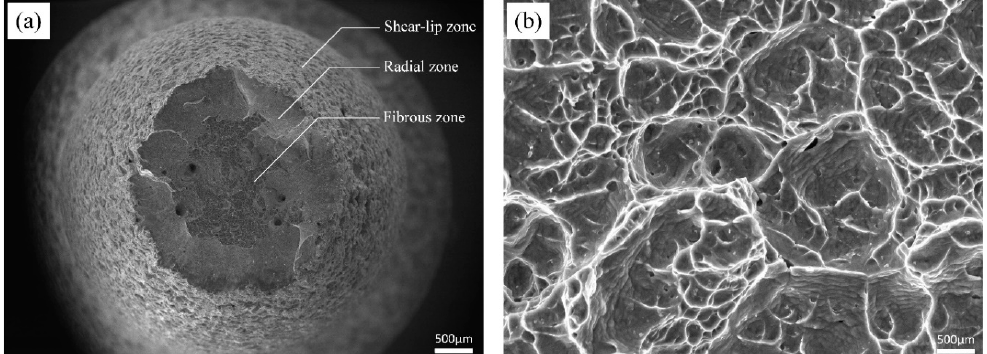
Figure 7. ( a ) Tensile fractography of β -Ti21S shows three zones as ductile manner. ( b ) Detail illustrating the fibrous zone.